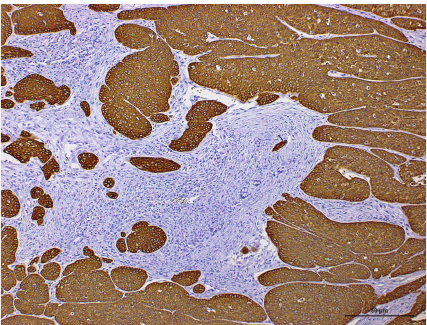
Figure 3: Immunolocalization of AE1/AE3 in lymph node metas- tasis of nasal carcinoma. Positive signal can be observed as the brown color in the cytoplasm of the cells or in the cytoplasm with hematoxylin counterstain. Bar = 50 𝜇 m.